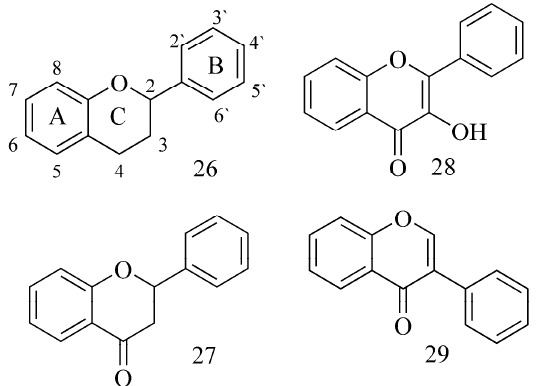
Figure 10. General chemical structures of flavonoid ( 26 ), flavanone ( 27 ), flavonol ( 28 ) and isoflavone ( 29 ) rings. ( 29 )